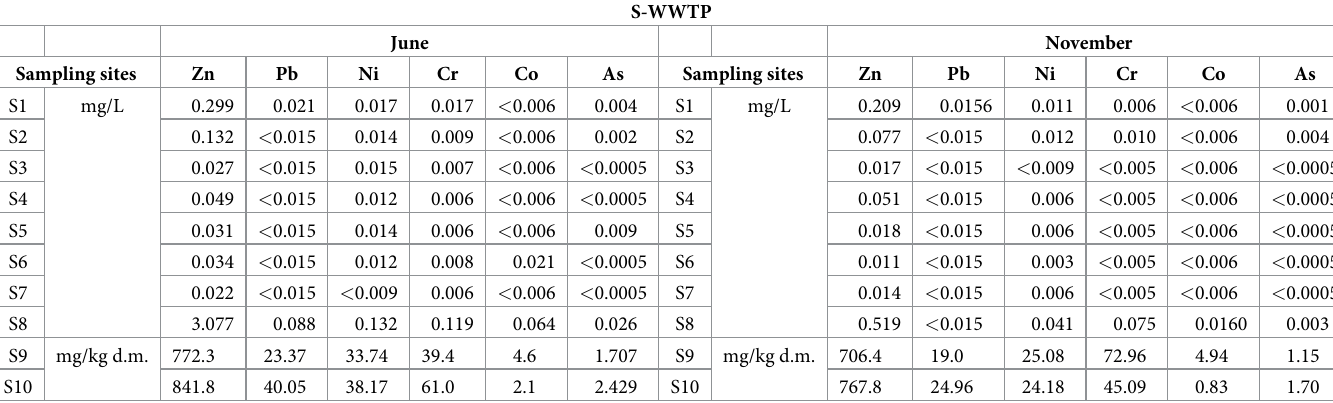
Table 3. Average concentration of analyzed heavy metals (mg/L and mg/kg d.m.) in samples from